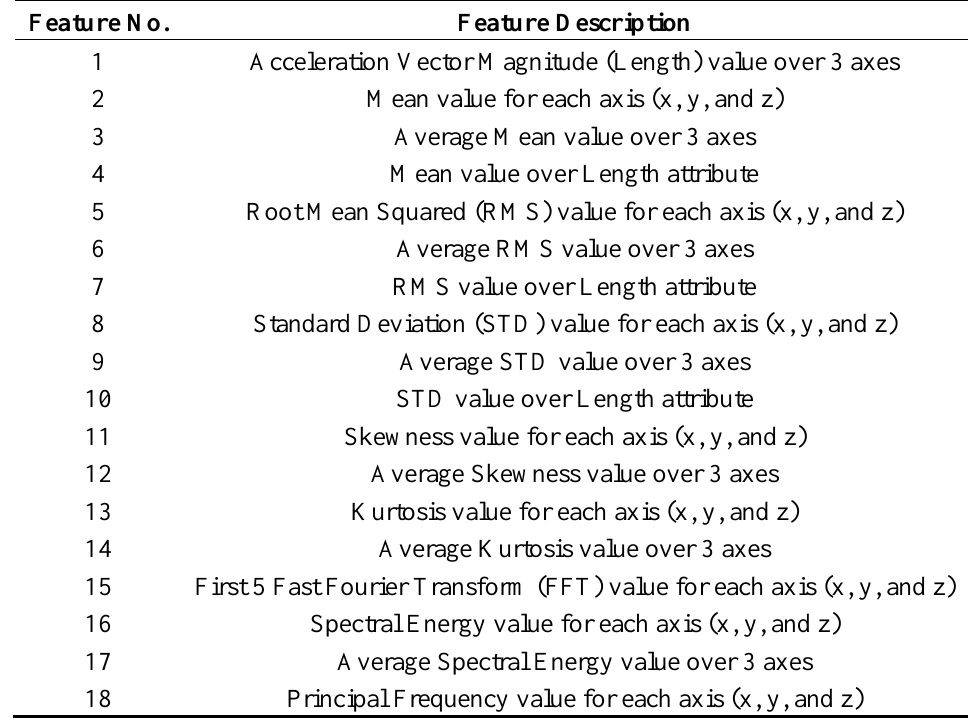
Table 3. Features extracted from each window of raw acceleration